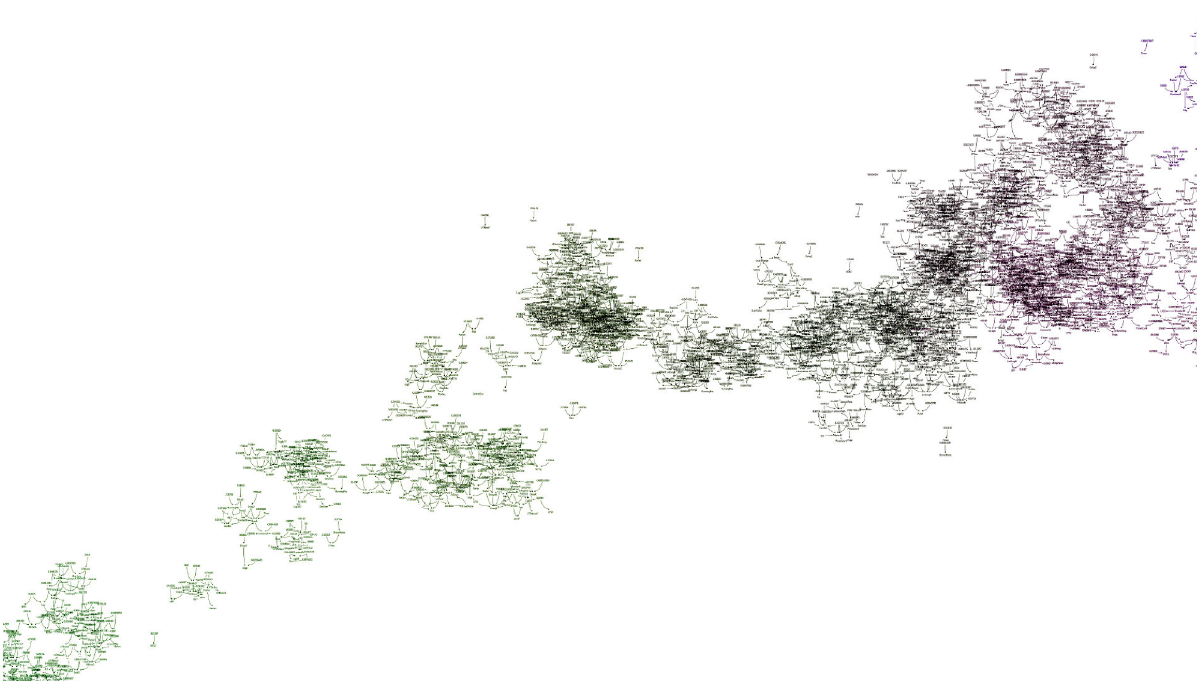
Figure 6 | Section from a path unwinding in Grenzwerte . Each data point is visualised by the corresponding UGen graph, the colour gradient describes the temporal